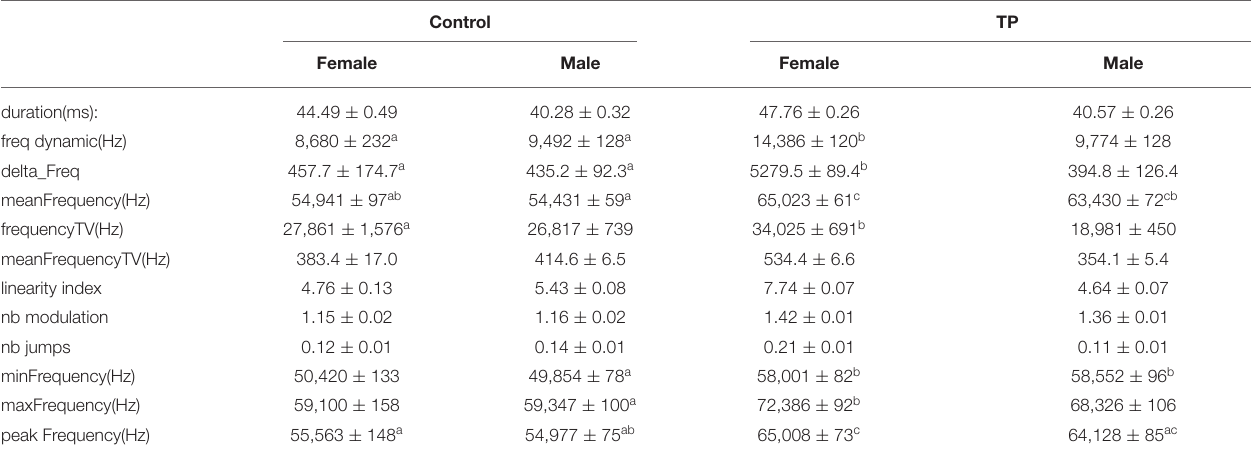
TABLE 1 | The group comparisons of acoustic parameters.